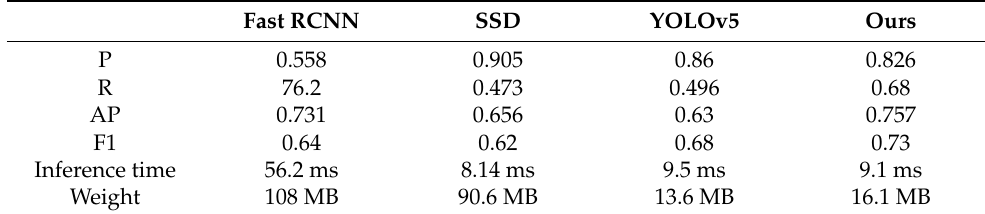
Table 3. Performance comparison of detection